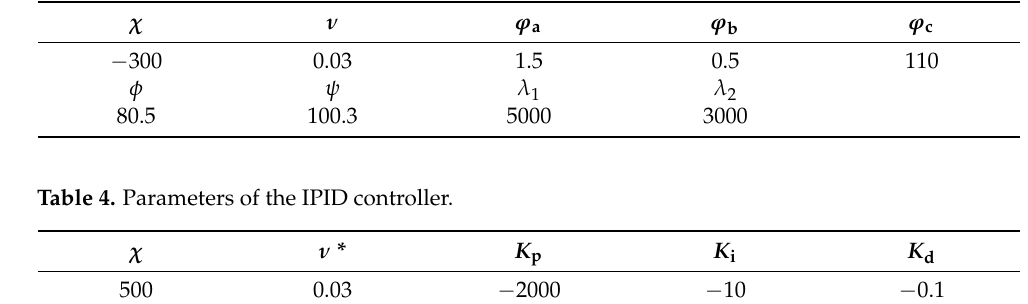
Table 3. Parameters of the LFOSMC controller.